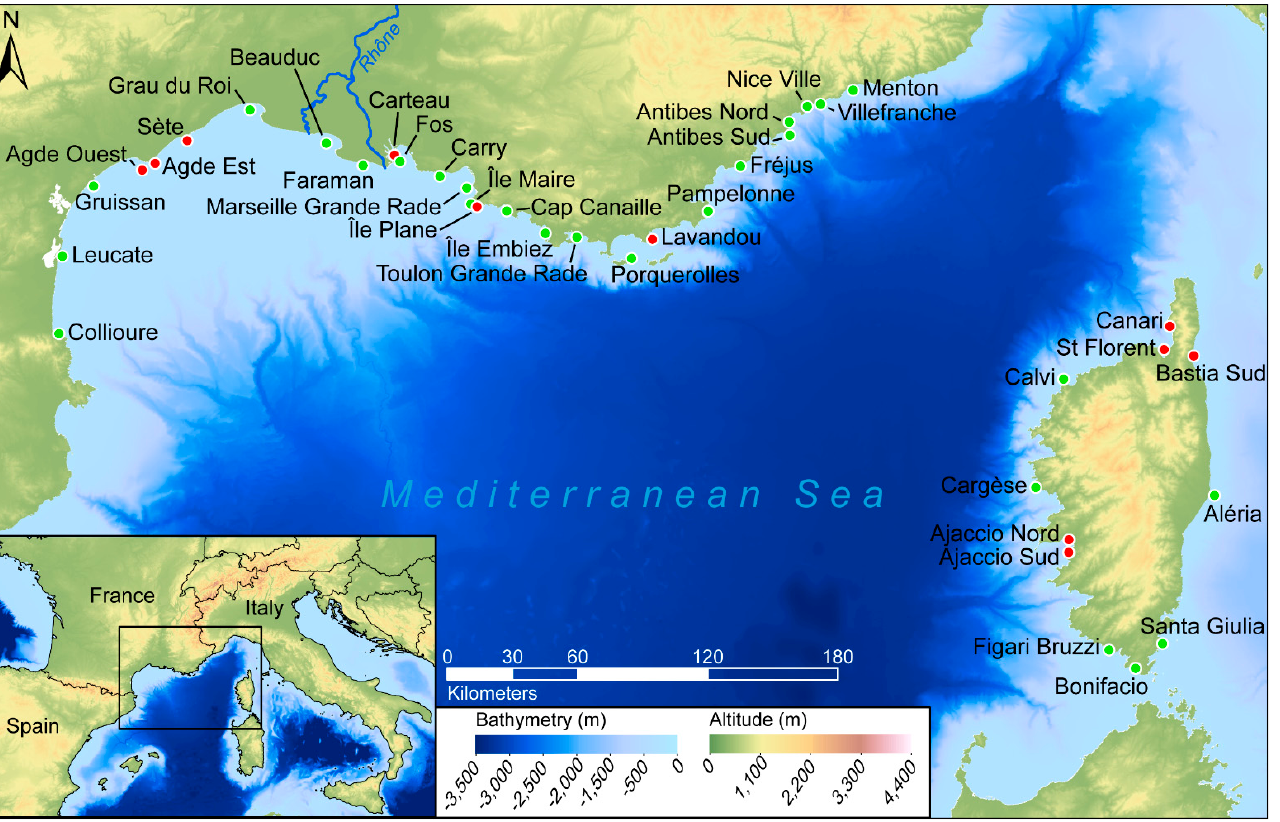
Figure 1. Sampled stations during the two surveys (2012 and 2015). The stations sampled during both surveys are in green, stations only sampled in 2012 or 2015 are in red. See Table S1 for details. Digital elevation models are from Jarvis et al. [46] and Marine Information Service [47].